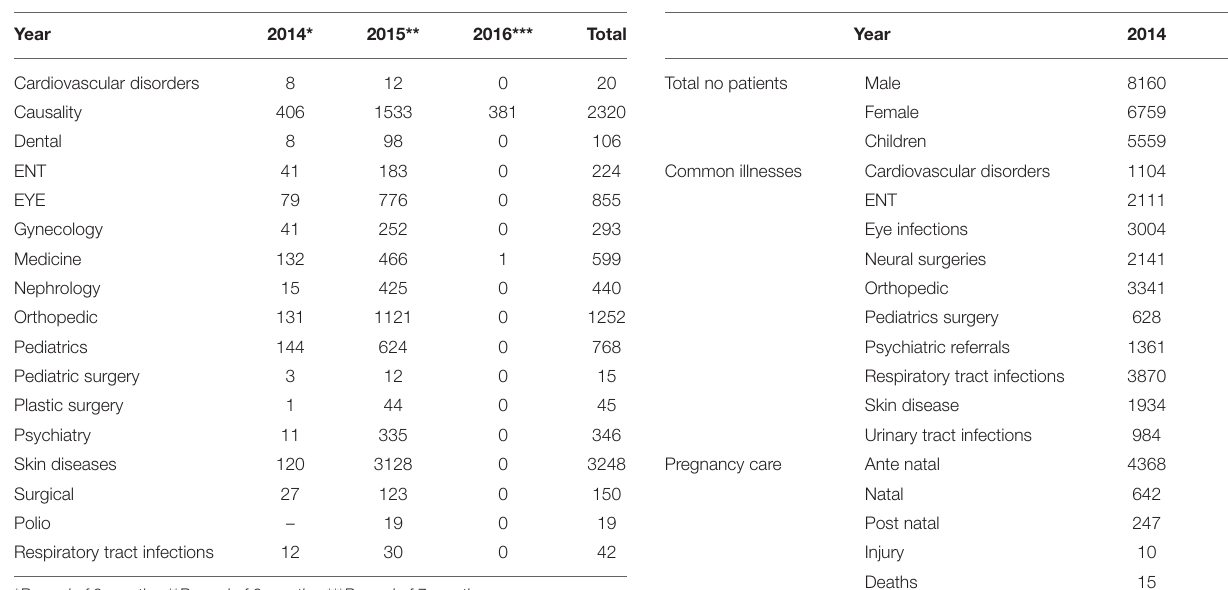
TABLE 7 | Health status of IDPs in